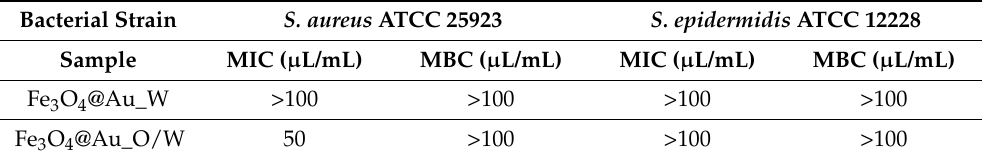
Table 2. Antimicrobial activity of analyzed particle suspensions. Bacterial Strain